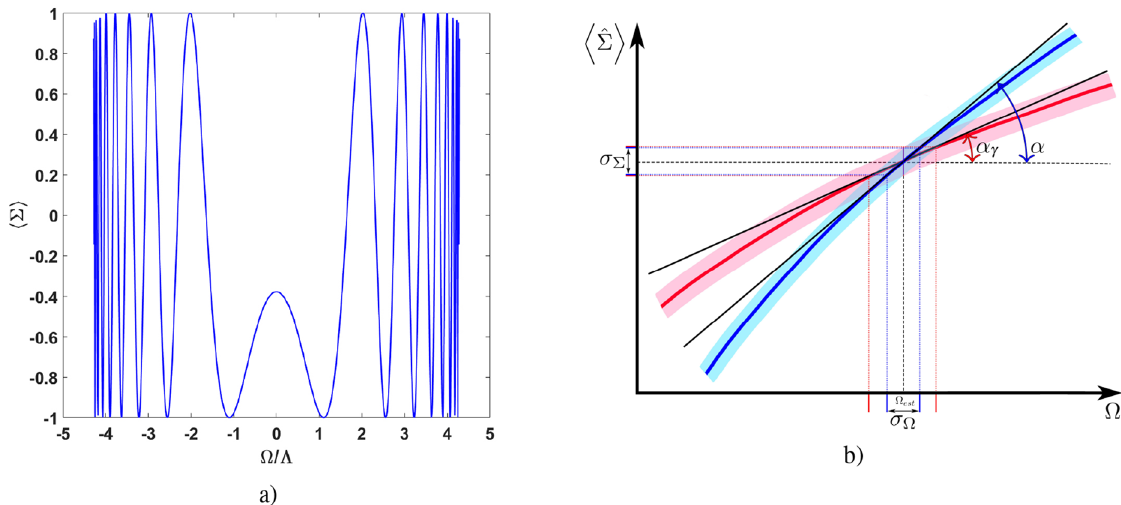
(cid:31) Figure 8. ( a ) Mean value vs. normalized angular frequency �/� for ( a ) the whole interval of (cid:31) , and ( b ) in ˆ 200 . In ( b ) the blue and red curves the vicinity of estimated value (cid:31) est , respectively. The particle number is N (cid:31) (cid:30) = characterize some fragment of the interference pattern without and with incoherent (extra) noises, respectively. α The solid black lines denote tangents to these curves. Relevant angles α ( tan [ ] = (cid:31) ) describe the tangent slopes at the points corresponding to the estimated parameter (cid:31) est � without and with weak losses γ , respectively; is the mean value of measured parameter (cid:31) in the presence ˆ γ (cid:31) (cid:30) of losses. For the blue curve some uncertainty σ � ≡ (cid:31) and estimation performed with error σ � . The shadow regions exhibit relevant uncertainties in (cid:31) as functions of (cid:31) . See more details in the